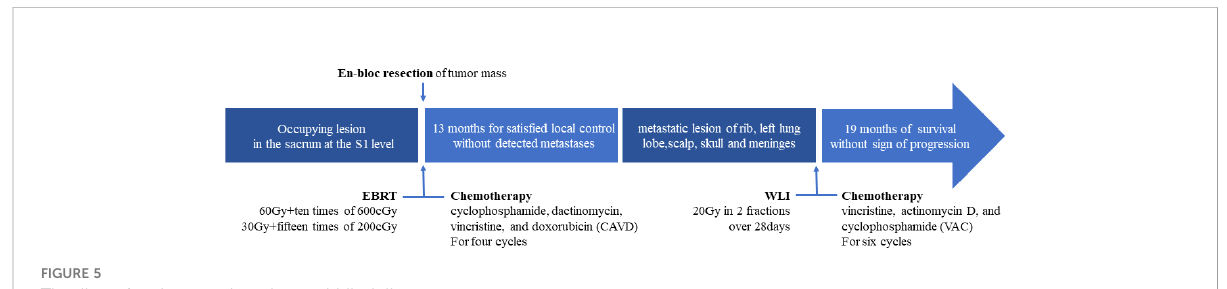
FIGURE 5 Timeline of patients undergoing multidisciplinary